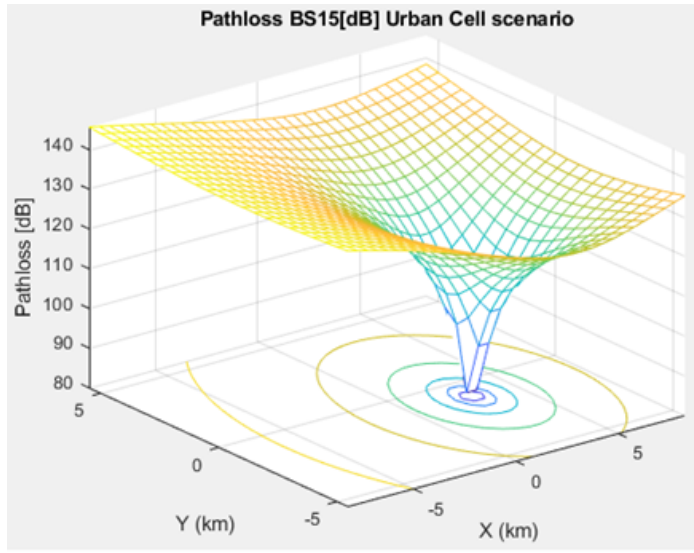
Figure 5. Path loss model for BS No. 15 in a microcell scenario.